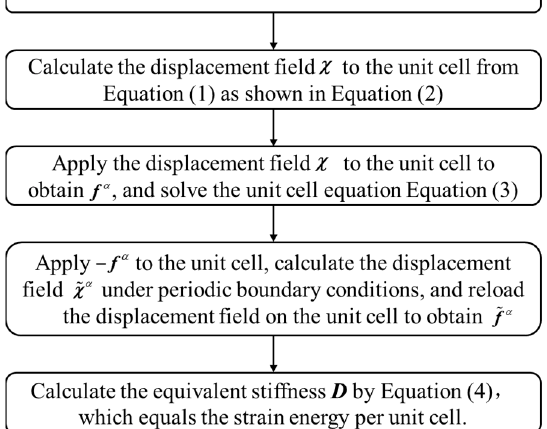
Figure 3. Flowchart of NIAH method to calculate equivalent stiffness.